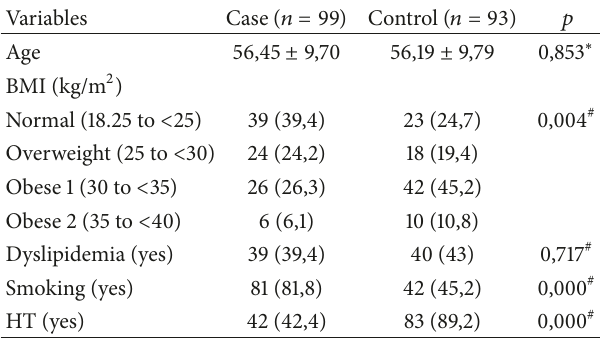
Table 2: Baseline characteristics.